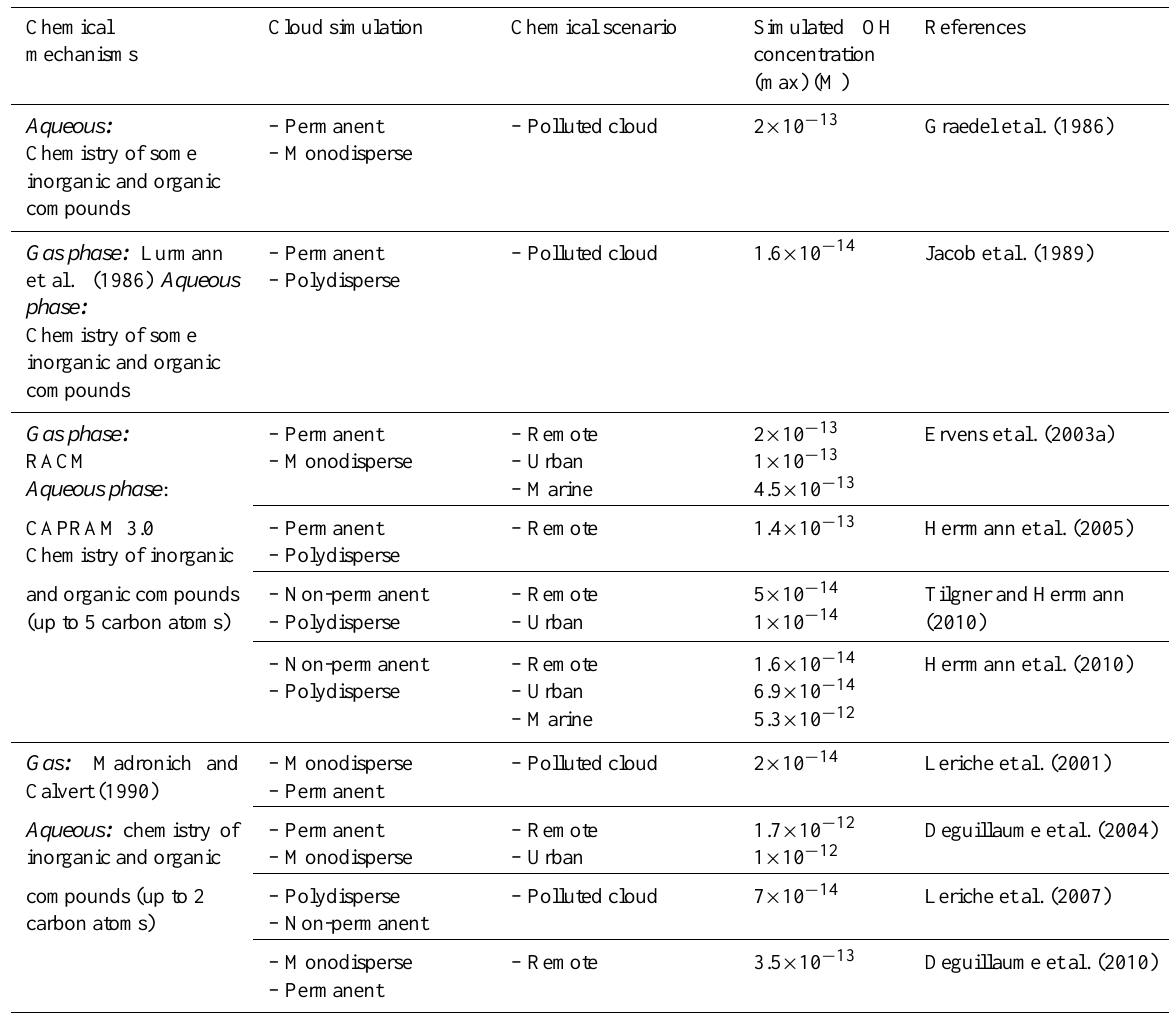
Table 4. Maximum aqueous OH concentrations simulated by various multiphase cloud chemistry models. These models consider different explicit chemical mechanisms and simulate clouds with different microphysical properties (monodisperse to